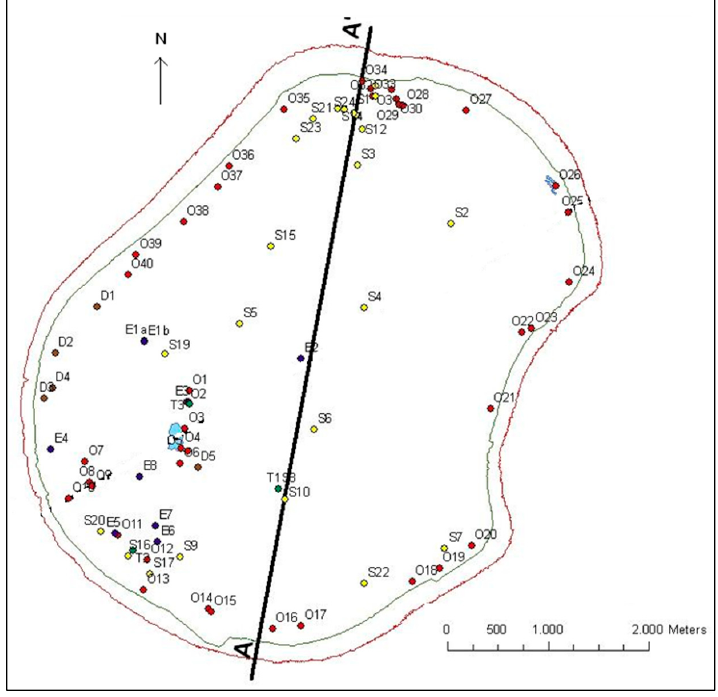
Figure 8. Section AA’ trace and monitoring points present in the island.